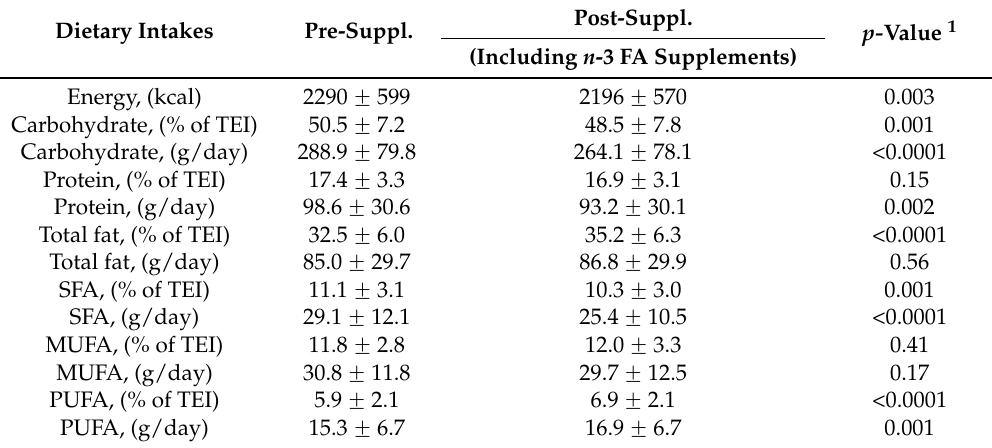
Table 3. Dietary intakes pre- and post-supplementation with n -3 PUFAs ( n = 191). Dietary Intakes Pre-Suppl.